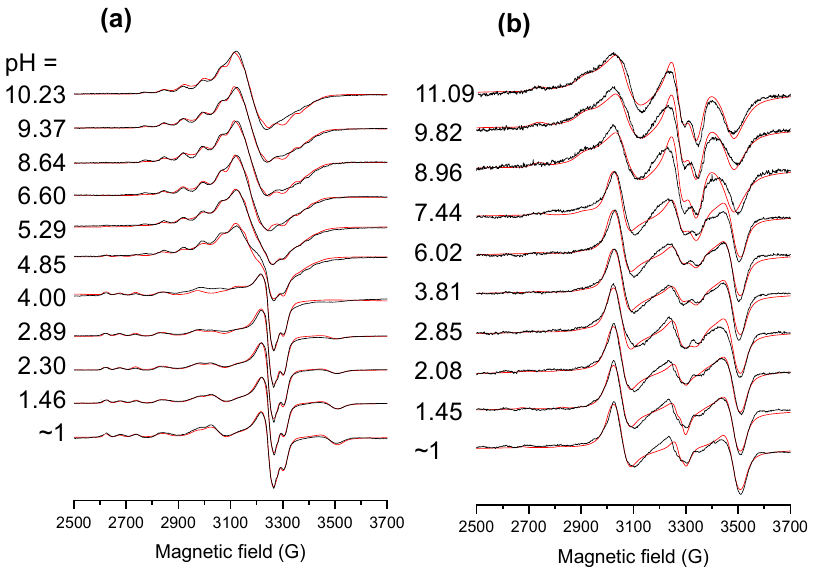
Figure 5. Experimental (black) and simulated (red) frozen solution EPR spectra recorded at various pH values for the Cu(II)-HQNO 2 -L-Pro system at ( a ) 1:1 and ( b ) (1:2) Cu(II):ligand ratio in 30% ( v / v ) DMSO/H 2 O. { c ligand = 500 μM; c Cu(II) = 500 or 250 μM; I = 0.10 M KCl; T = 77 K}.